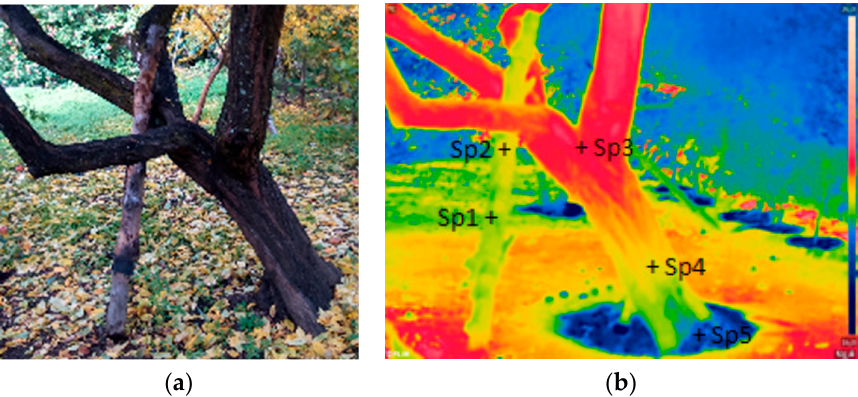
Figure 2. A tree ( Prunus domestica L.) and a wooden stake supporting it: ( a ) photograph; ( b ) IRT thermogram (passive mode). The temperature values (°C): Sp1 = 20.0; Sp2 = 20.5; Sp3 = 21.5; Sp4 = 20.5; Sp5 = 19.5. (Adapted from [21]).